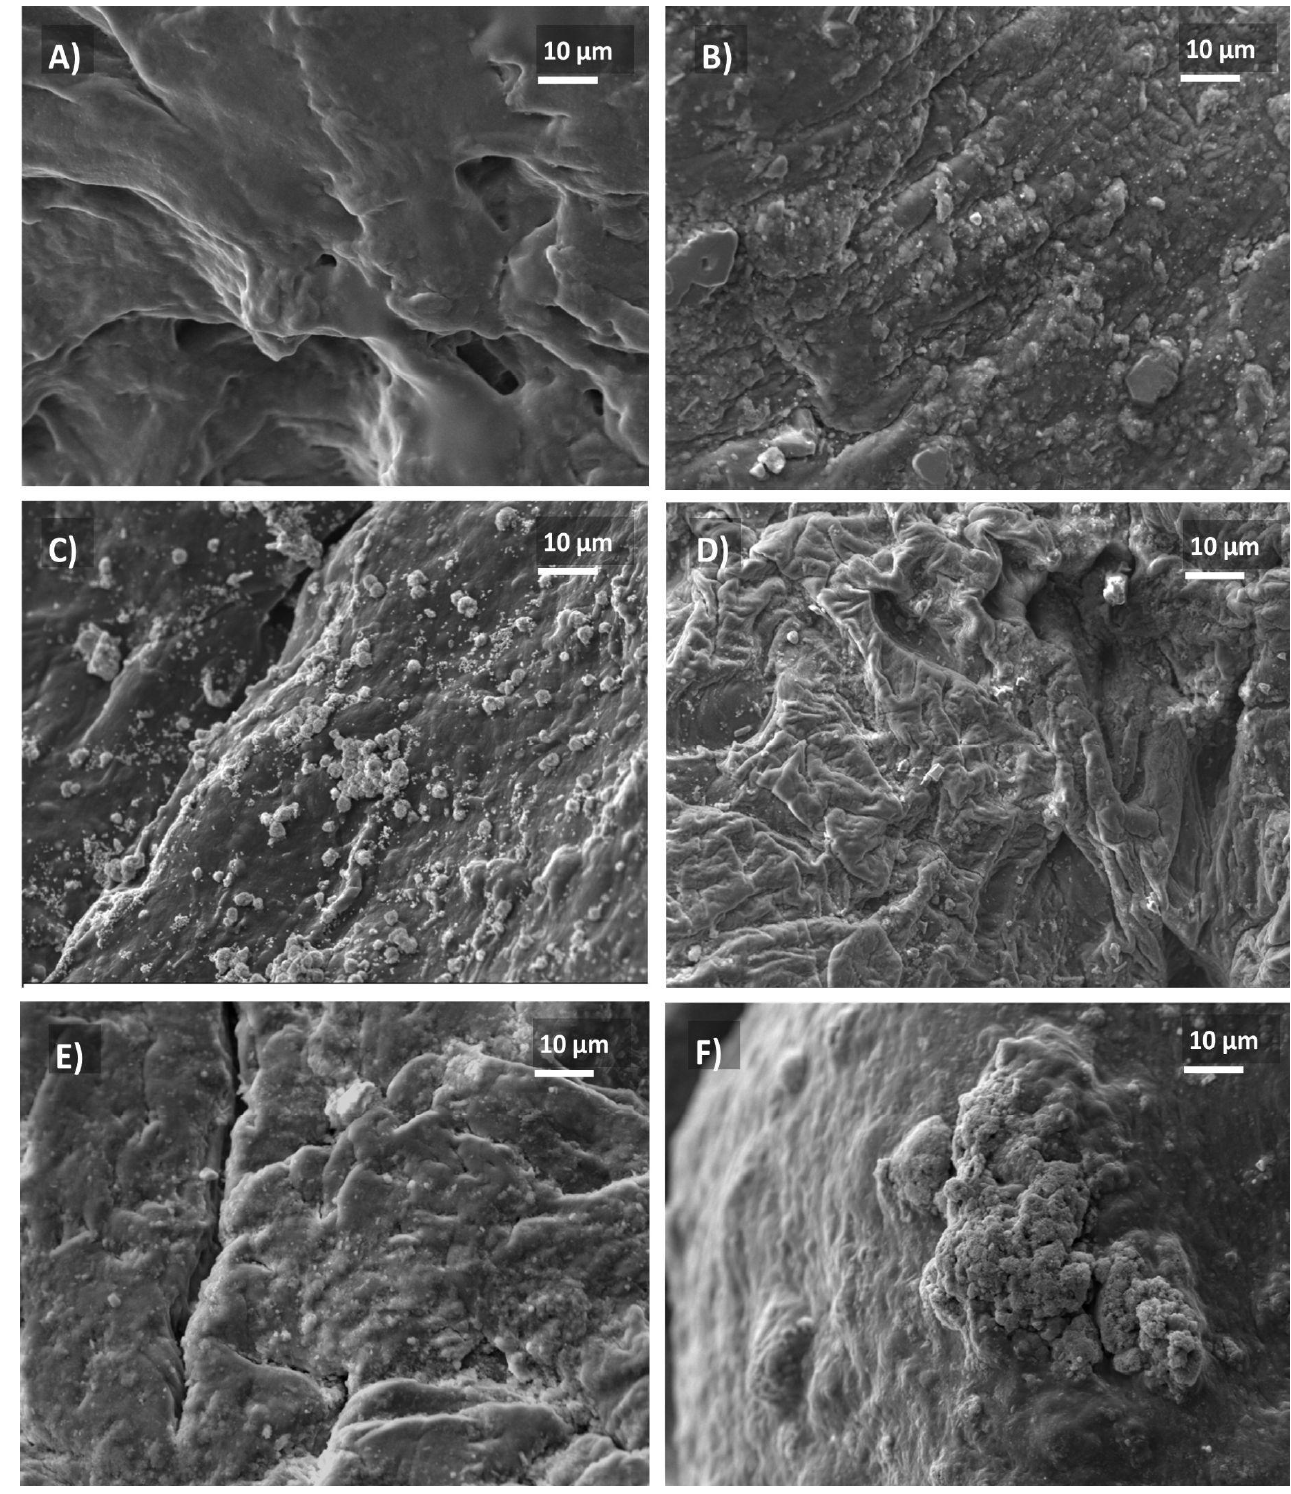
Figure 3. Micrographs of samples after soaking 21d in body fluids simulated ( A ) AG1 (control); ( B ) AG2 (Al 2 O 3 ); ( C ) AG3 (Na 2 Ti 6 O 13 ); ( D ) AG4 (TiO 2 ); ( E ) AG5 (ZrO 2 ); and ( F ) AG6 (WO 3 ).